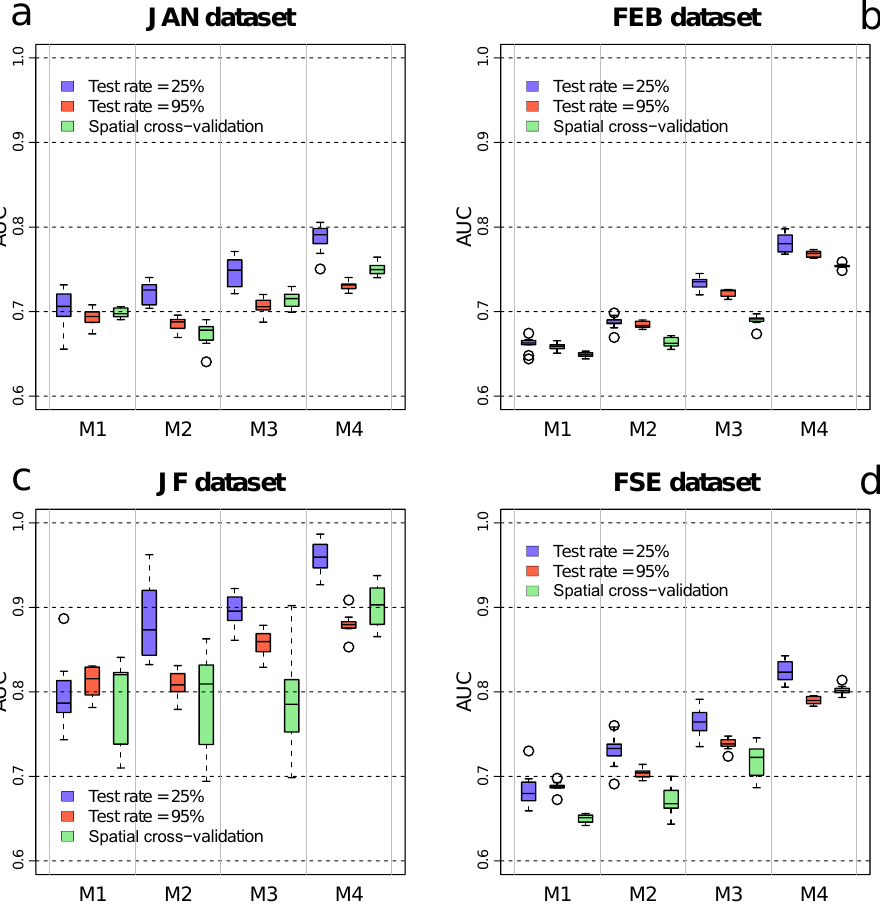
Figure 10. Box plots of the AUC values achieved by the M1, M2, M3 and M4 models, measured on the validation samples of the datasets JAN ( a ), FEB ( b ), JF ( c ) and FSE ( d ) for the three validation scenarios (Scenario 1: test rate 25%; Scenario 2: test rate: 95%; Scenario 3: 5-fold spatial CV).